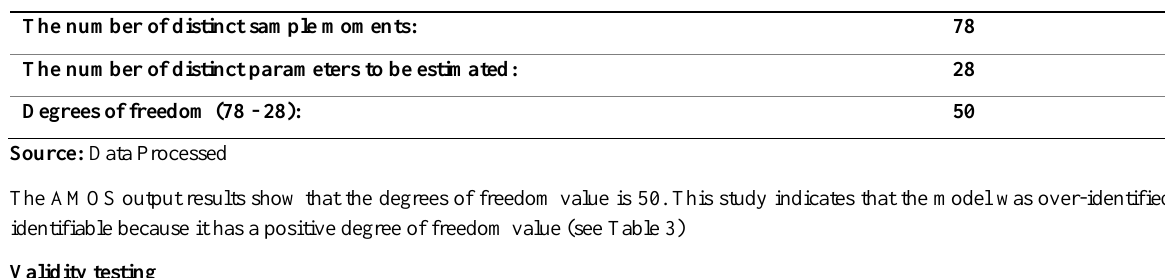
Table 3: Computation of degrees of